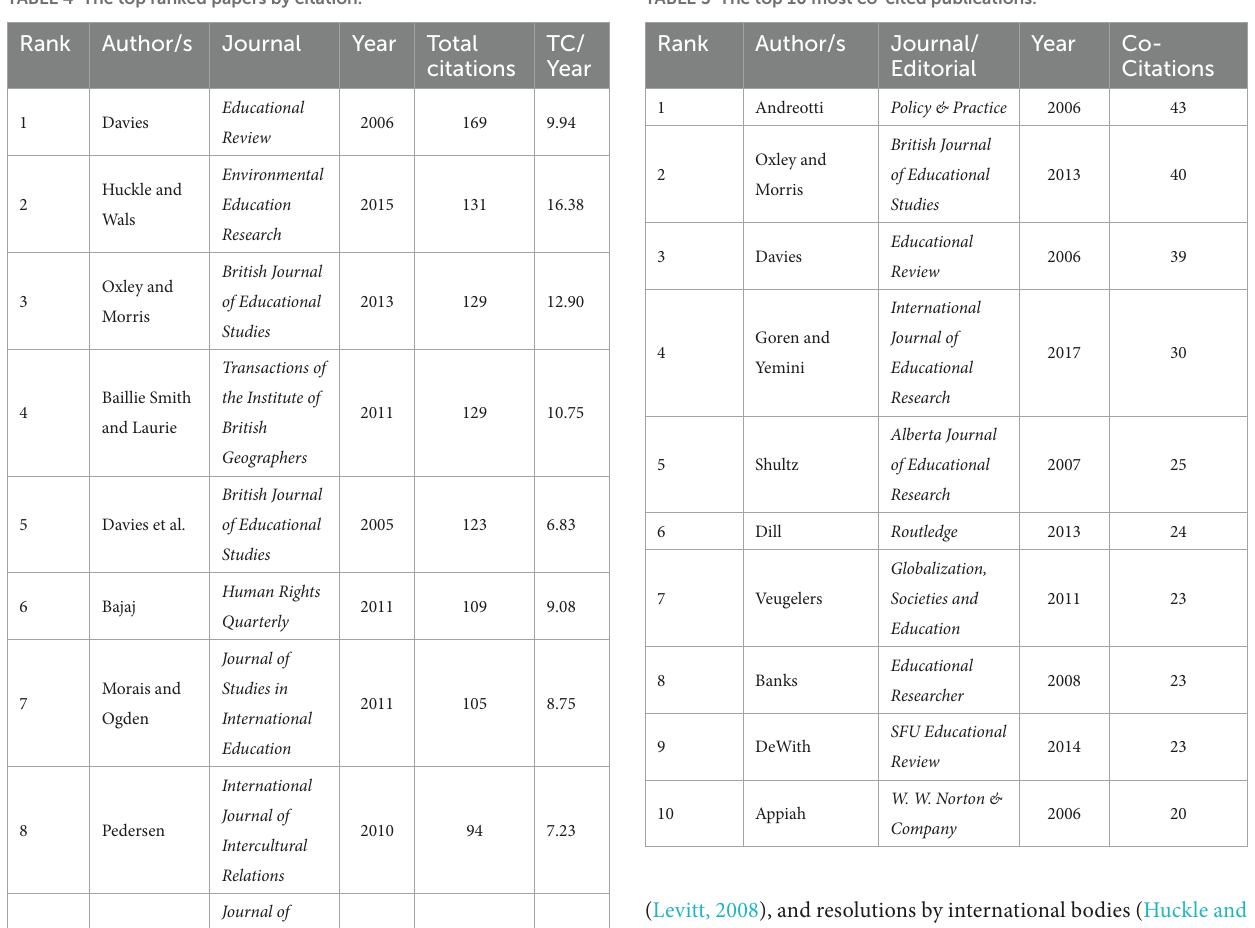
TABLE 4 The top ranked papers by citation. TABLE 5 The top 10 most co-cited